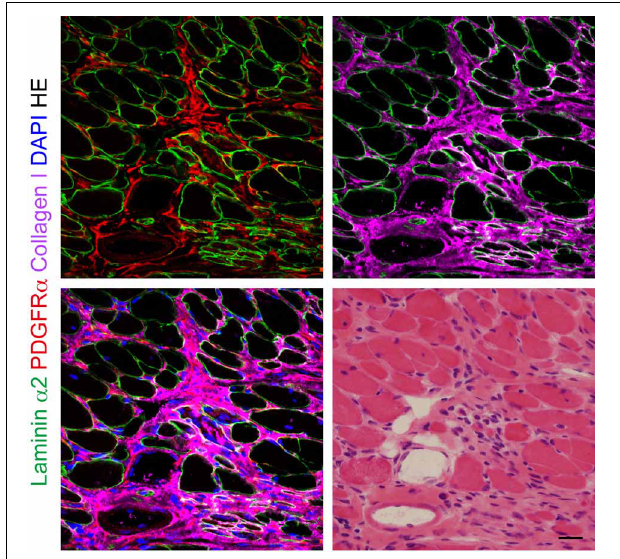
FIGURE 2 | The behavior of PDGFR α + mesenchymal progenitors in dystrophic muscle. Fresh frozen section of mdx diaphragm subjected to immunofluorescence staining for laminin α 2, PDGFR α , and collagen I, and subsequently to HE staining. Scale bar: 20 μ m.